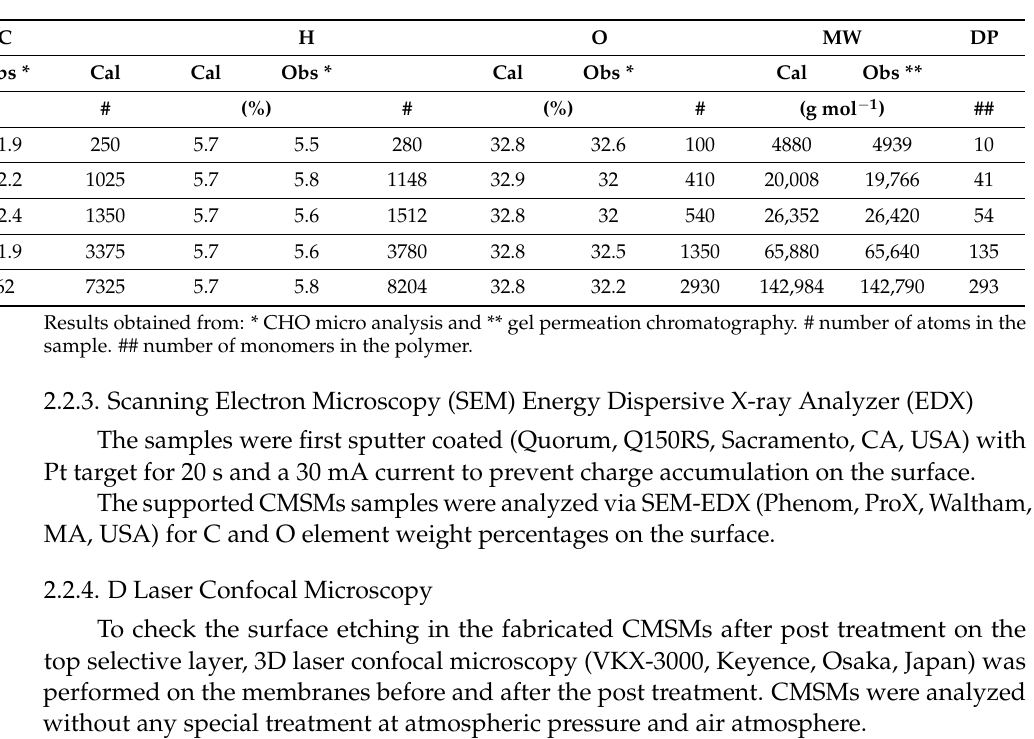
Table 1. Gel Permeation Chromatography (GPC) results of Degree of Polymerization (DP) and Molecular weight (Mw) of resorcinol-formaldehyde polymer.